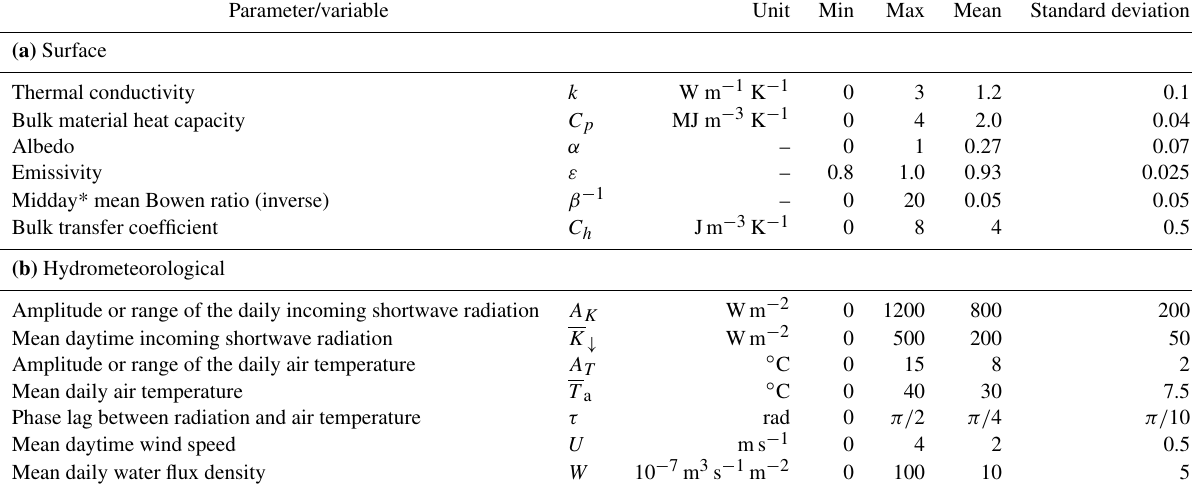
Table 1. Range of values used as basis for the sensitivity analysis: (a) surface parameters and (b) hydrometeorological variables. All are assumed to have normal PDF. Values of surface parameters are based on values reported in Stull (1988).